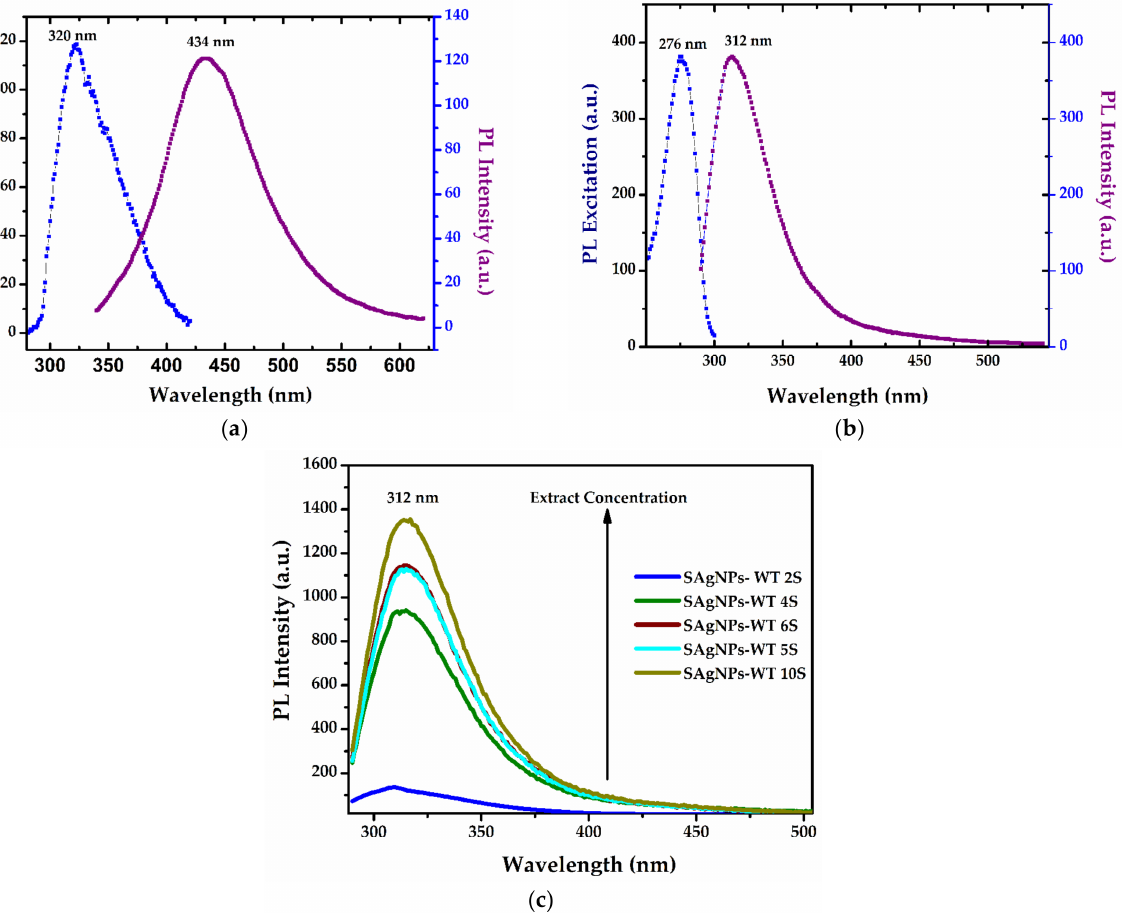
Figure 6. Photoluminescence excitation (PLE) and emission (PL) spectra recorded for the SAgNPs-WT colloidal dispersion at ( a ) 320 nm excitation; ( b ) band characteristics of tyrosine at λ ex/ λ em = 276/312 nm; and ( c ) increases in the band of tyrosine (312 nm) with the concentration of the extract during